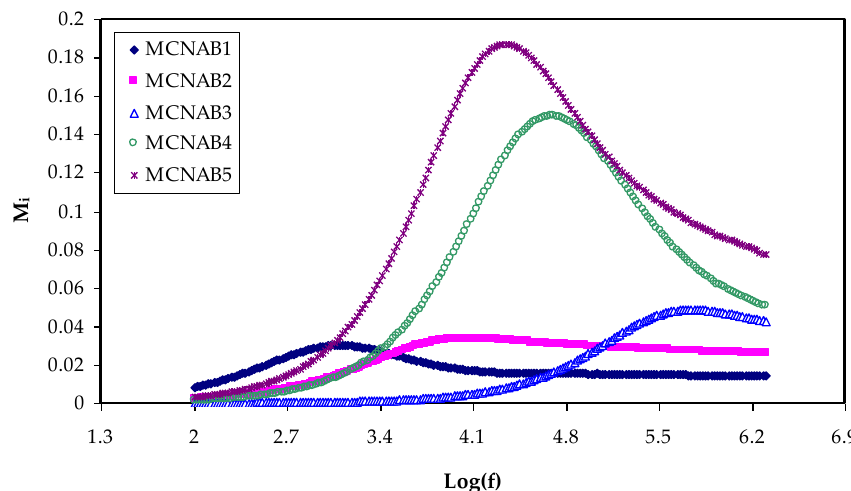
Figure 11. M i against frequency at room temperature for each sample.